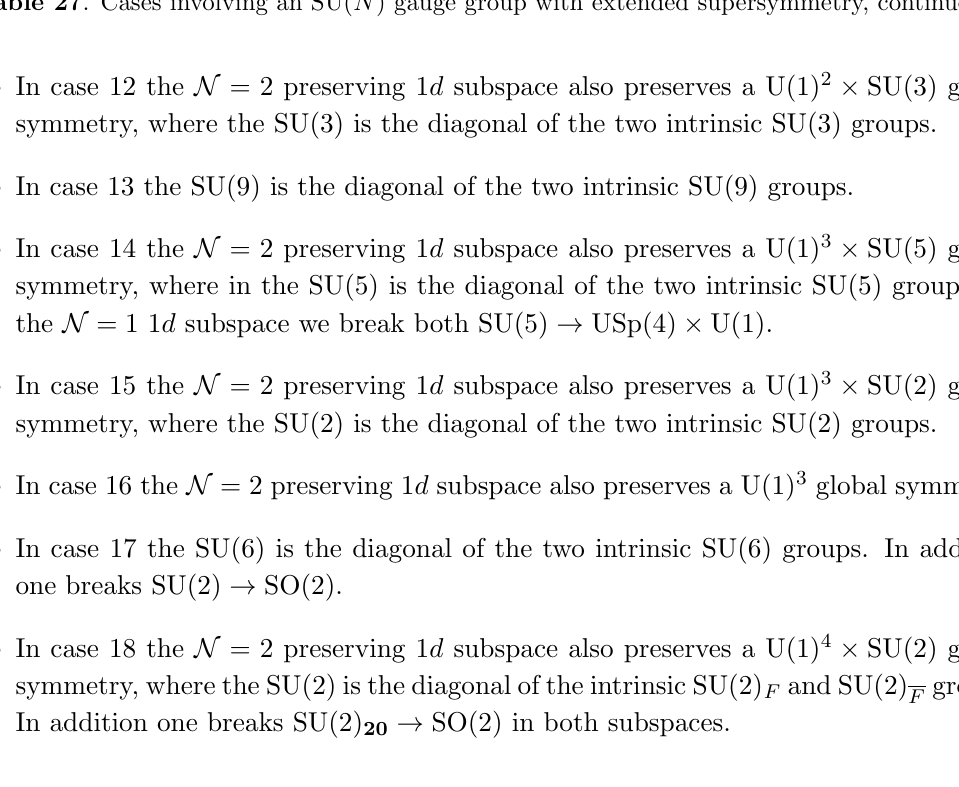
Table 27 . Cases involving an SU( N ) gauge group with extended supersymmetry,